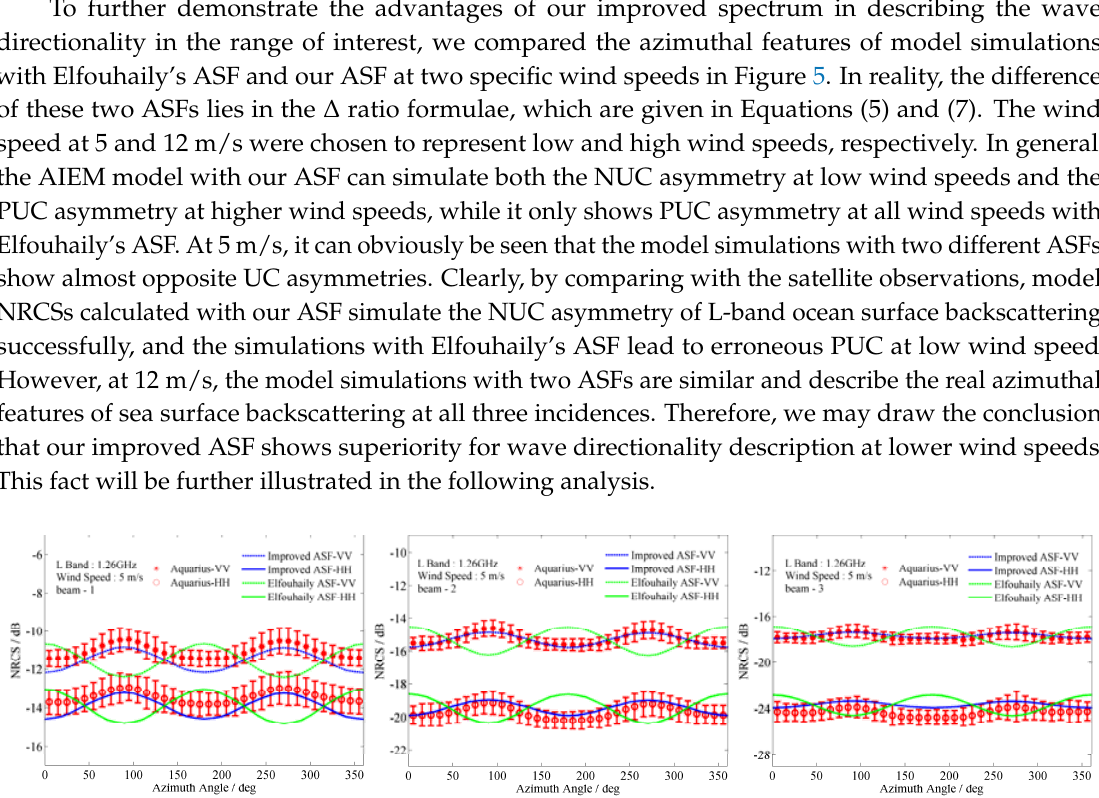
represent 1 SD ± of the matchup data. Blue dashed lines and solid lines are model simulations for VV and HH polarization, respectively.